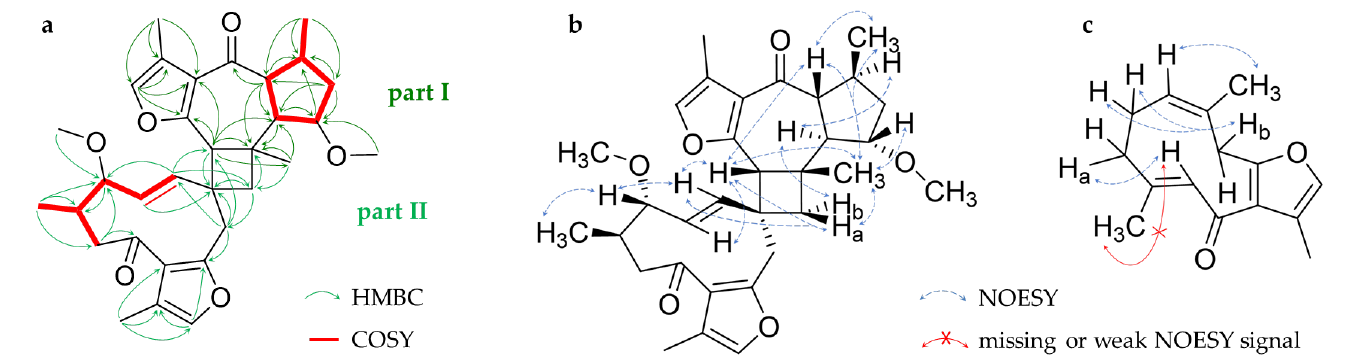
Figure 6. Key HMBC, COSY ( a ) and NOESY correlations for compound 8 ( b ) and key (missing) NOESY signals for compound 13 ( c ).